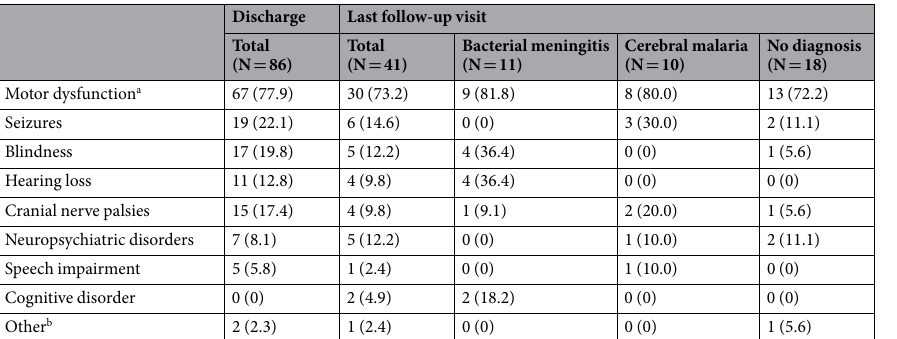
Table 4. Neurological sequelae identified at discharge and at the last follow-up visit among all, bacterial meningitis and cerebral malaria cases. a Including hemiplegia/paresia, quadriplegia/paresia, extrapyramidal rigidity, hypotonia, hypertonia, and cerebellar ataxia. b Including foot drop, regressed